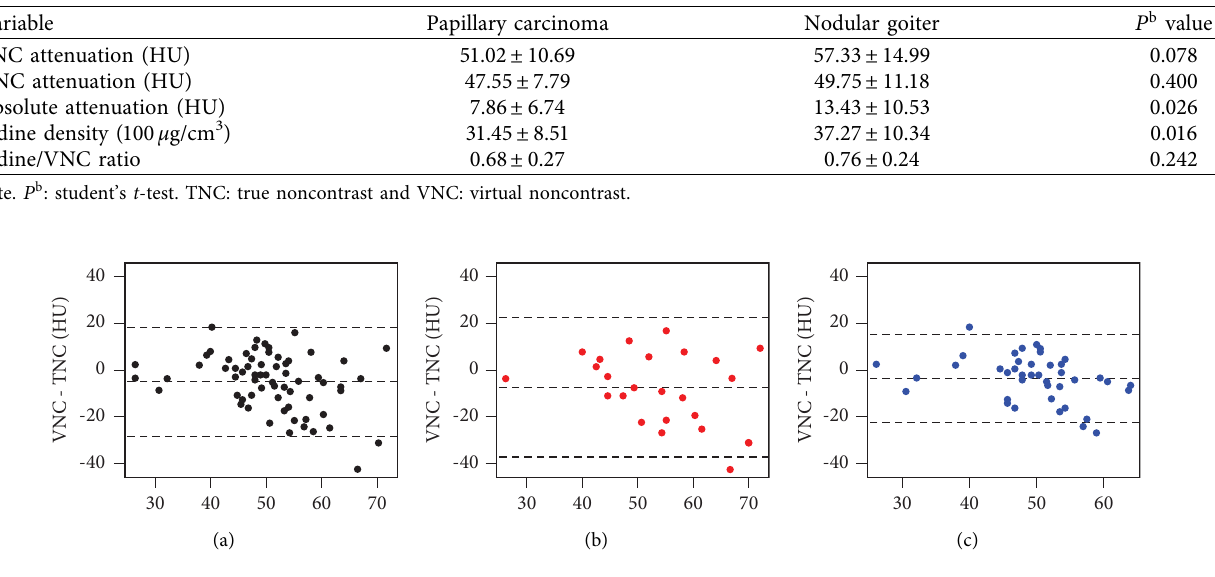
Table 4: Quantitative analysis of TNC and VNC between papillary carcinoma and nodular goiter.